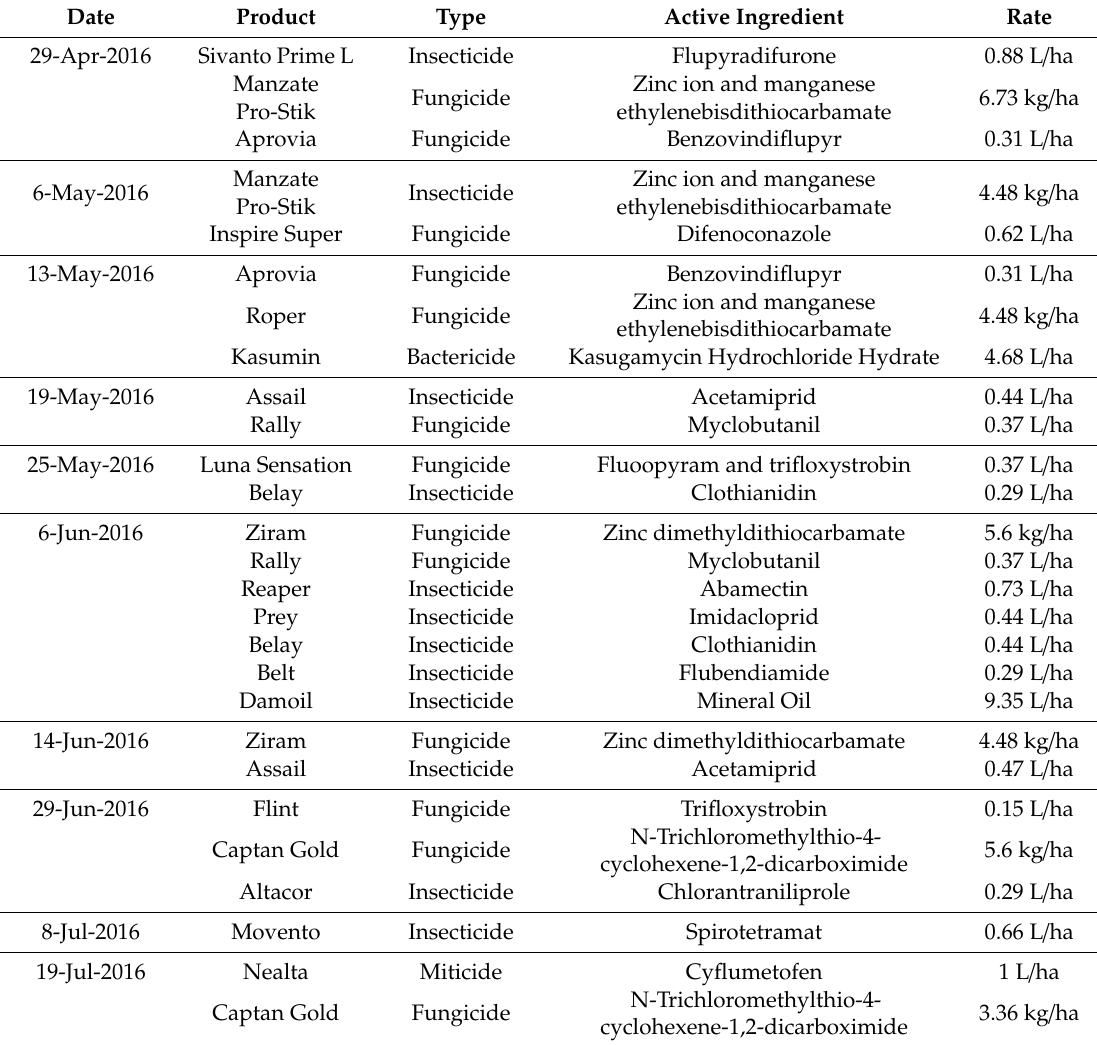
Table 2. Schedule of pesticide applications made through the airblast sprayer and SSCDS system in for season long pest